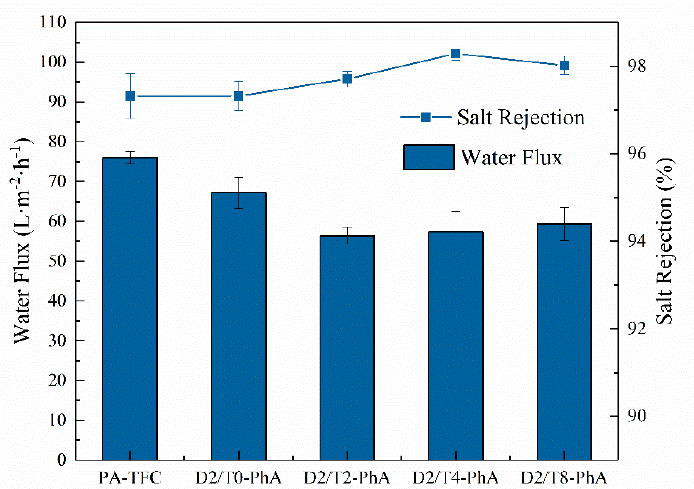
Figure 4. The permselectivity of the PA-TFC membrane and the DA/TA-PhA membranes.